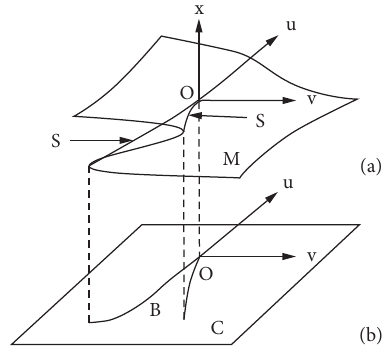
Figure 1: Cusp catastrophe model surface map.